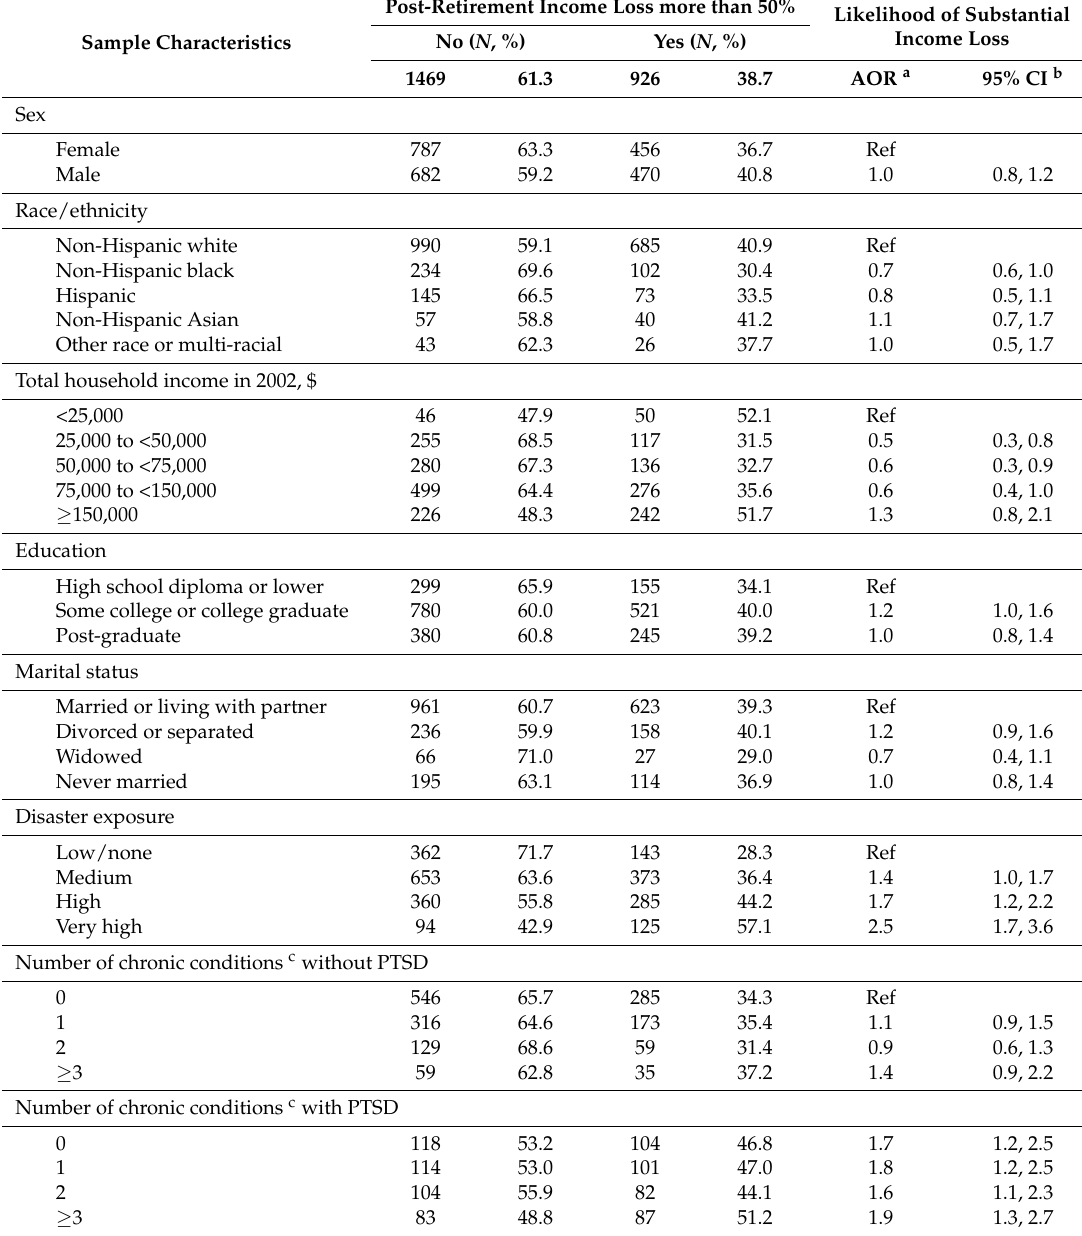
Table 3. Post-retirement income loss, chronic physical health conditions and post-traumatic stress disorder (PTSD) comorbidity, and other characteristics among retirees reporting decreased income.